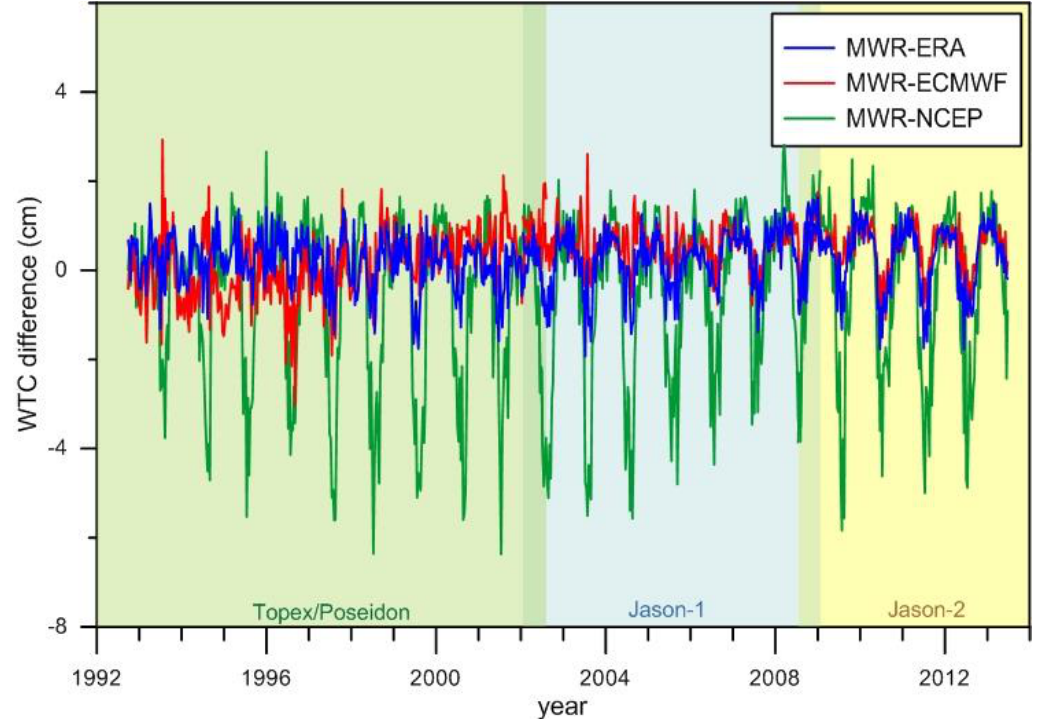
Figure 13. Mean cycle differences between the MWR-derived WTC and the corresponding values from three models, over the Caspian Sea, for T/P Phase A, Jason-1 Phase A and Jason-2. Only measurements over inland water with valid MWR correction were considered.